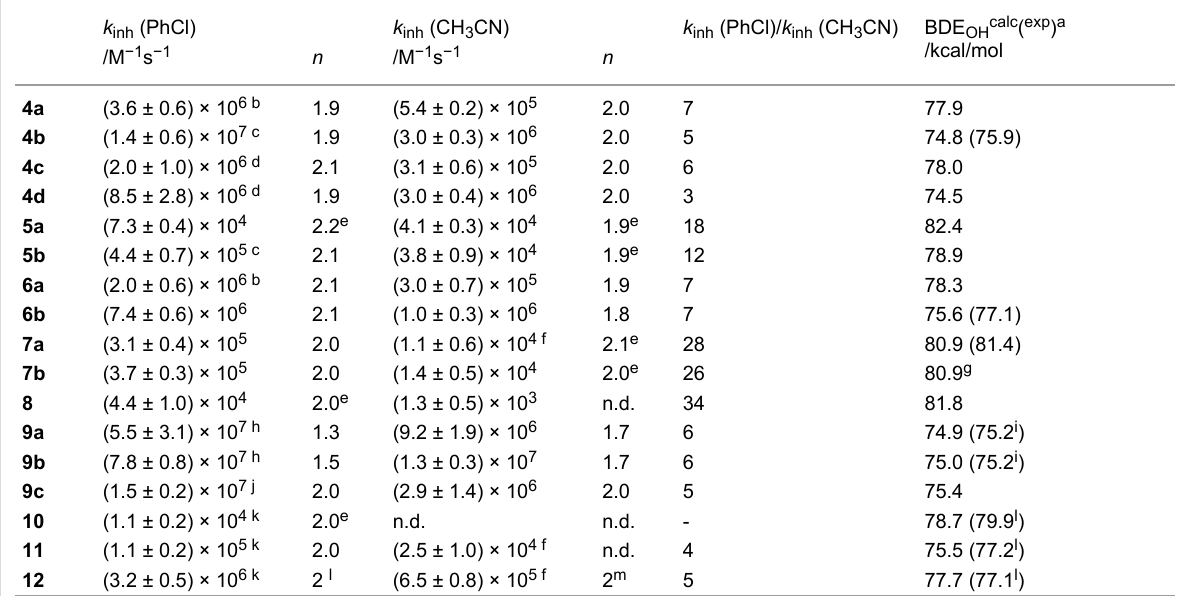
Table 1: Rate constants for the reactions of 4 – 12 with peroxyl radicals ( k inh ) at 303 K obtained from AIBN-initiated inhibited autoxidations of styrene (50% v/v) in either chlorobenzene (PhCl) or acetonitrile (CH 3 CN). O–H Bond dissociation enthalpies calculated using CBS-QB3 are given along with available experimental data where